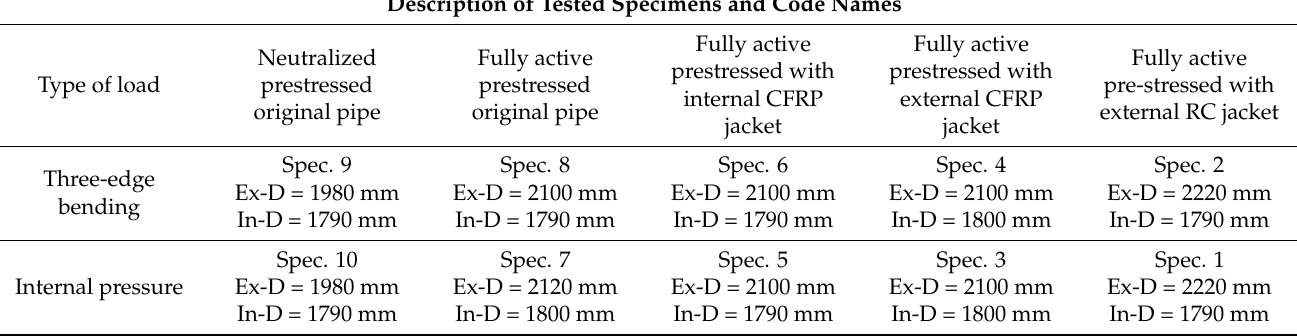
Table 1. Description of the tested